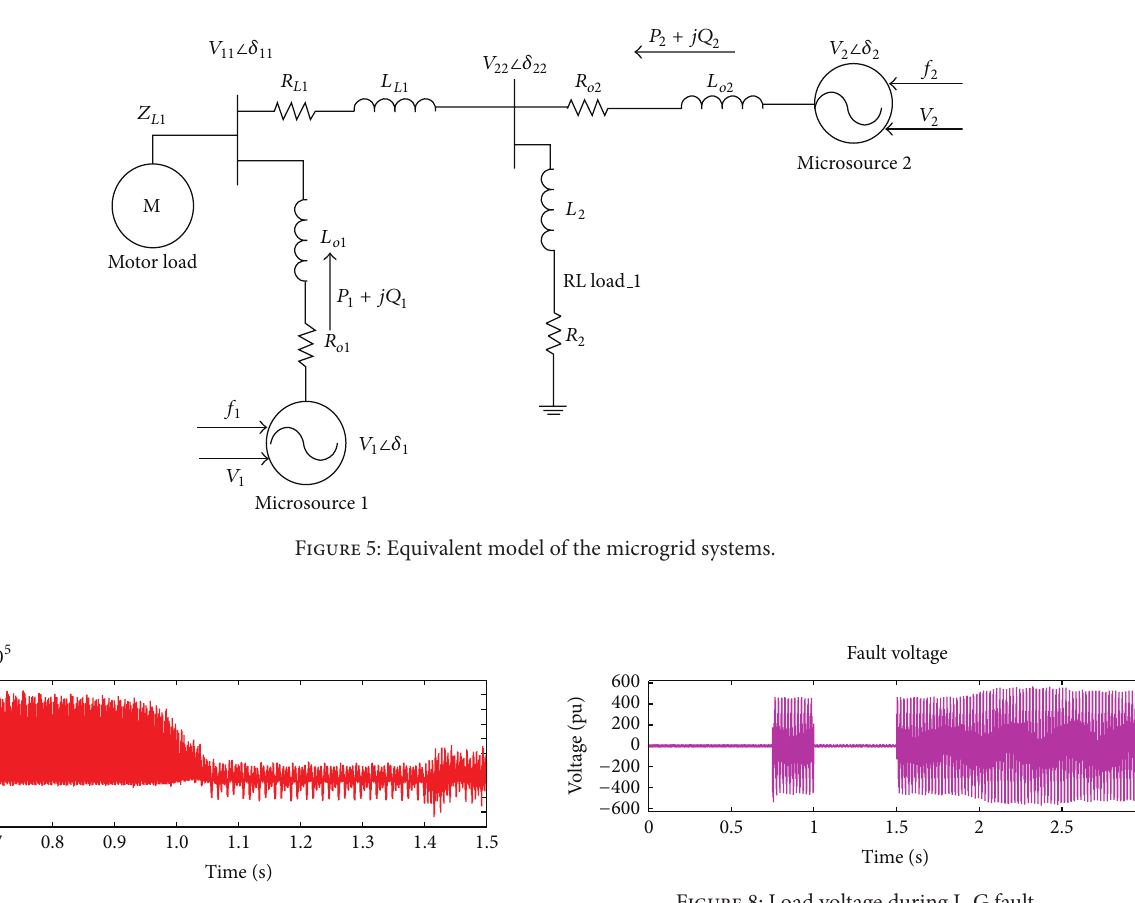
Figure 6: Real power during L-G fault.